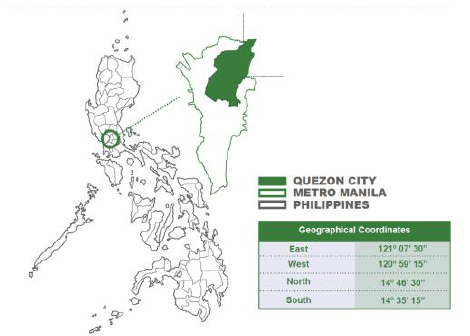
Figure 1. Quezon City in Metro Manila, Philippines